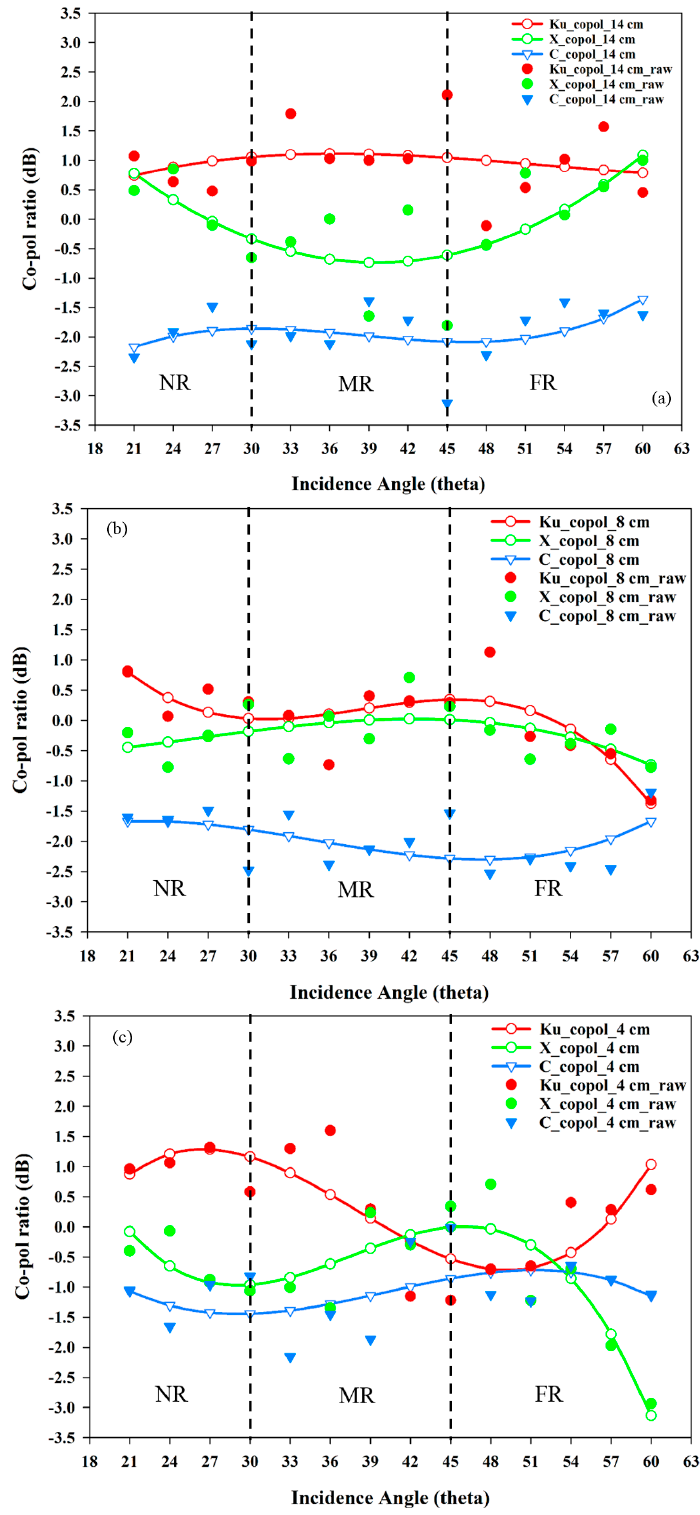
Figure 6. Calculated Ku-, X- and C-band co-pol ratios ( γ co ) from 14 cm, 8 cm and 4 cm snow covers on FYI: ( a ) Ku-band; ( b ) X-band; and ( c ) C-band. Co-pol ratio trend lines are cubic fits. Colored points represent measurement points. Vertical black dotted lines partition near-range (NR), mid-range (MR) and far-range (FR) incidence angles.